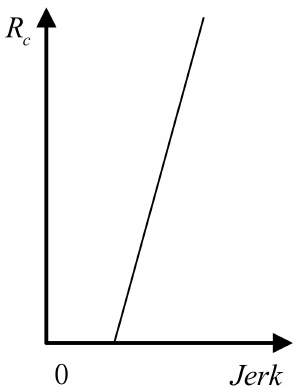
Figure 6. Comfortableness penalty